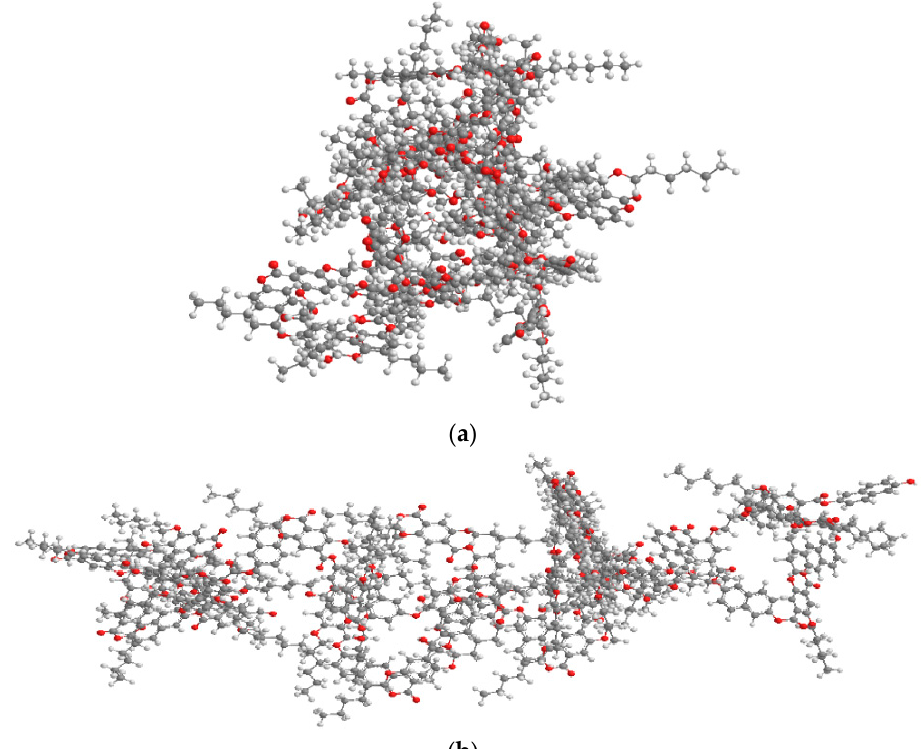
Figure 5. Comparison of the 3D chemical structures of ( a ) HQ-6 and ( b ) Naph-6.